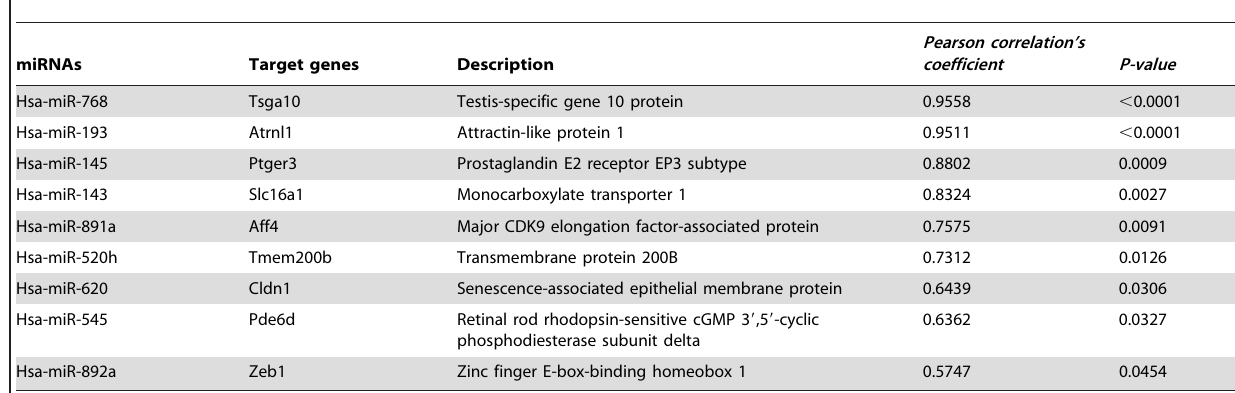
Table 2. List of selected miRNAs that displayed a positive correlation with their predicted target mRNAs.